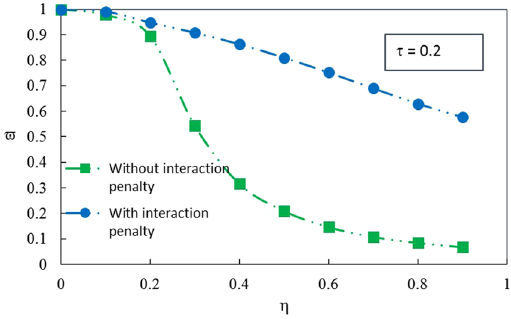
Figure 4. A comparison of the free vibration frequency of the delaminated laminate with/without interaction penalty at the interfaces of the delamination from finite element